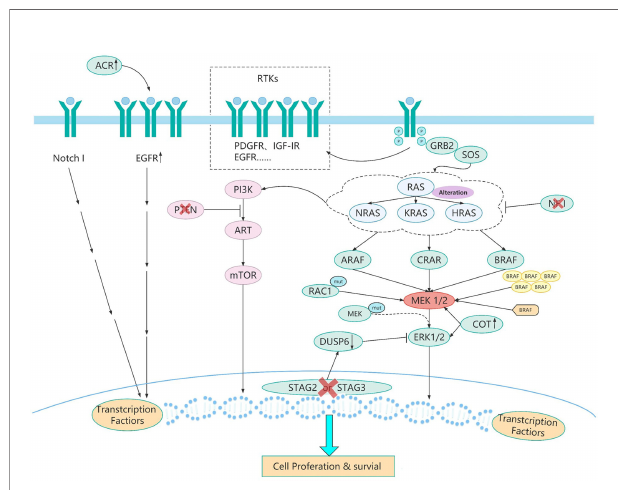
FIGURE 2 | The resistance pathways of BRAF inhibitor. BRAF mutated tumor cells evolve different drug resistance pathways to maintain cell growth after chronic inhibition by BRAF inhibitors. These evolutionary mechanisms ( Table 2 ) include BRAF splice variants, BRAF copy number ampli fi cation, CRAF overexpression, MEK1 mutations, and other mechanisms. Different pathways of BRAF evolution can tell us how to overcome the problem of resistance to BRAF inhibitors and how to develop more rational protocols to address the resistance